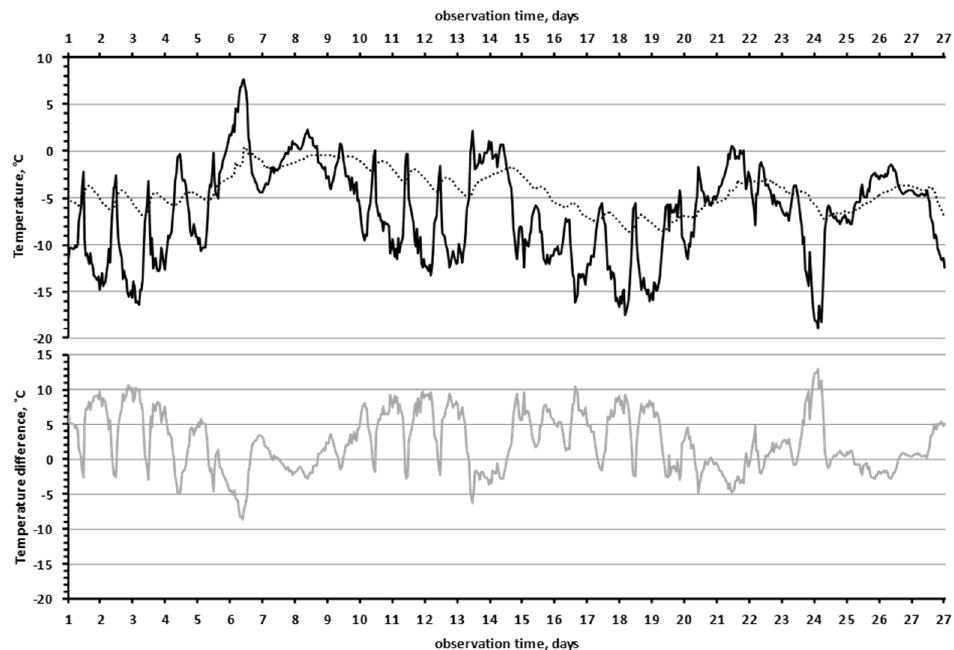
Figure 5. The lower the air temperature, the greater the temperature difference between the rock and the air (December 2019). The temperature of the air in the shade, 10 cm from the surface of the rock (black line). The temperature in the “slit” (dotted line). The temperature difference between the rock in the “slit” and the air (grey line).